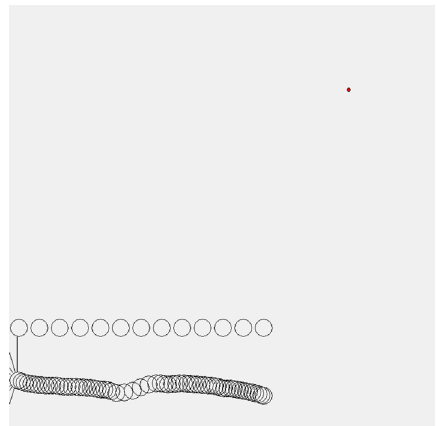
Fig. 17 Traditional reinforcement learning method